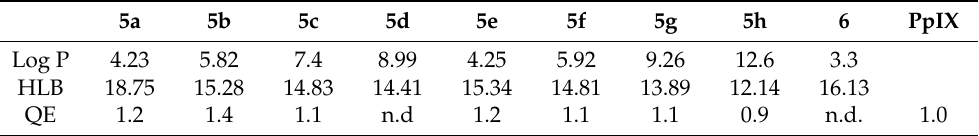
Table 1. Octanol–water partition coefficient (log p ) and hydrophilic–lipophilic balance (HLB) of porphyrins 6 and 5a – h computed by the MarvinSketch software. Additionally, the fluorescence quantum efficiencies (QE) of the compounds in THF relative to PpIX (set to 1.0 in column for PpIX) are included (n.d. means ‘not